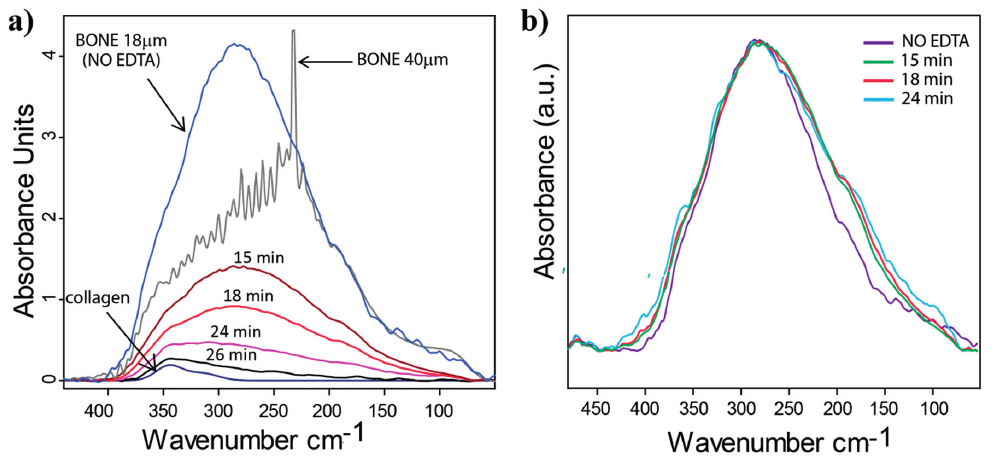
Figure 3. Far-IR spectroscopy at different stages of demineralization of fibrolamellar bovine bone. ( a ) the 18 µm-bone spectrum (fully mineralized, blue line), is plotted together with the 40 µm thick sample (grey line) and the series of spectra related to the demineralization